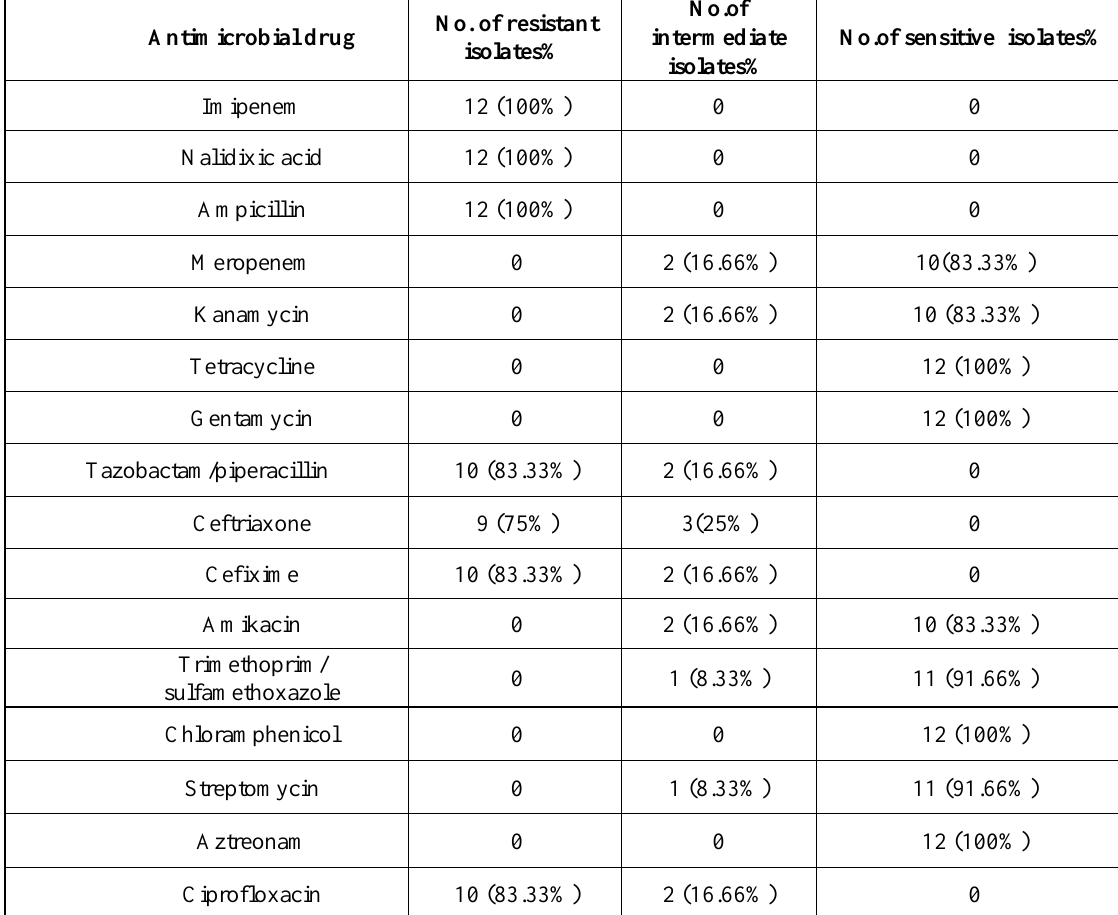
Table 2. Antimicrobial susceptibility pattern of Pantoea spp. isolates.